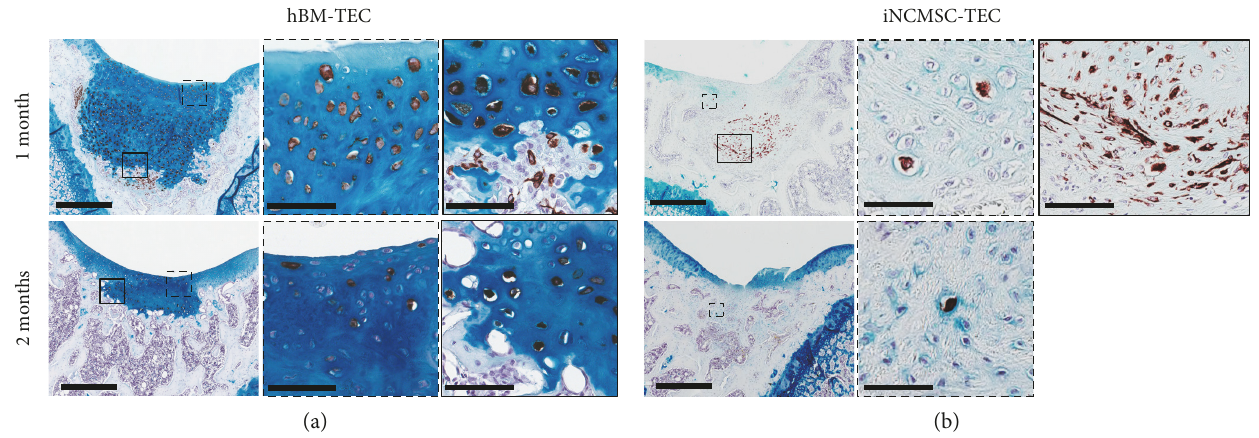
Figure 8: Vimentin and alcian blue staining of in vivo implanted TEC. (a, b) hVimentin/alcian blue staining for the hBM-TEC and iNCMSC- TEC groups at 1 month and 2 months. Right panels are magni fi cation images of inset boxes of the left panels. Scale bars =500 μ m and 50 μ m (high-magni fi ed images). Abbreviations: TEC: tissue-engineered construct; hBM: human bone marrow-derived mesenchymal stem cells; iNCMSC: induced neural crest-derived mesenchymal stem